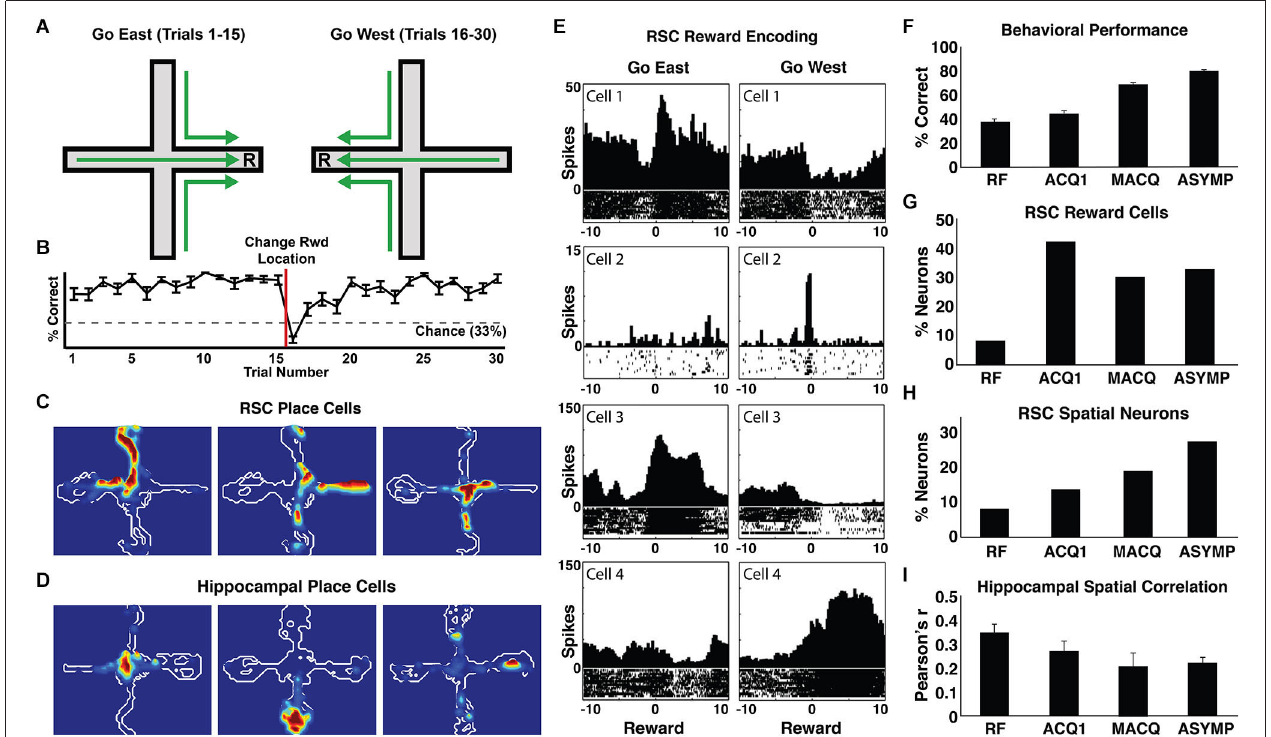
reward (cells 1–2). Other RSC neurons showed sustained elevated firing while the rat consumed the reward in one location, and decreased firing during the other reward (cells 3–4). (F) Navigation performance improved with training. The average percentage of trials in which the rats made the correct arm entry is shown for random foraging pretraining (RF), the first training session (ACQ1), the session half way through training (middle acquisition, MACQ), and asymptotic performance (ASYMP). (G) The proportion of RSC neurons that differentially encoded the two reward locations increased dramatically on the first day of training (when the reward locations became useful navigation cues) and then remained high throughout the rest of training. (H) The proportion of RSC neurons with place fields increased steadily with training. (I) Although the proportion of hippocampal neurons with place fields remained the same throughout training (not shown), the activity of these neurons became more distinct in the Go East and Go West conditions as the rats learned the task (average spatial correlations, Pearson’s r ). Adapted from Smith et al.